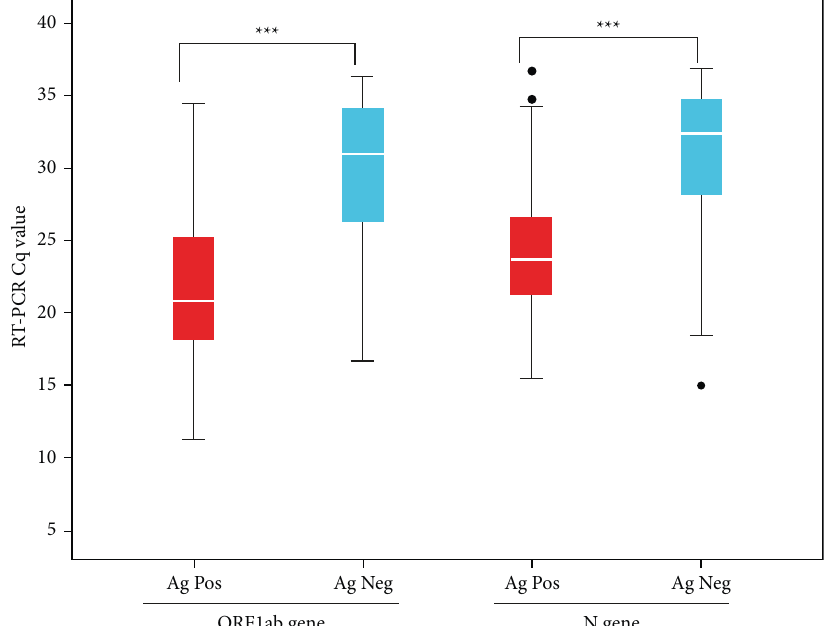
∗∗∗ represents p value < 0.001. q values.